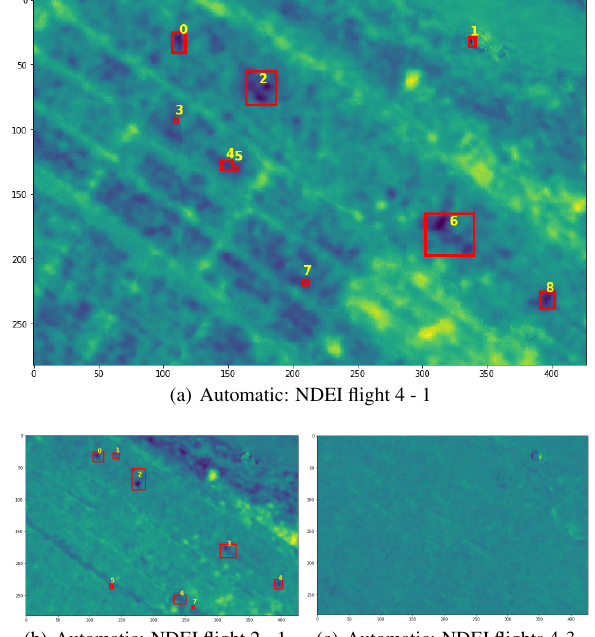
Figure 13. Automatic detection period: (a) January-December or flight 4 - 1 (Flight 4 4/2/2020 12:40PM - Flight 1 28/12/2019 12:10PM); (b) Flights performed on December 28, 2019 (Flight